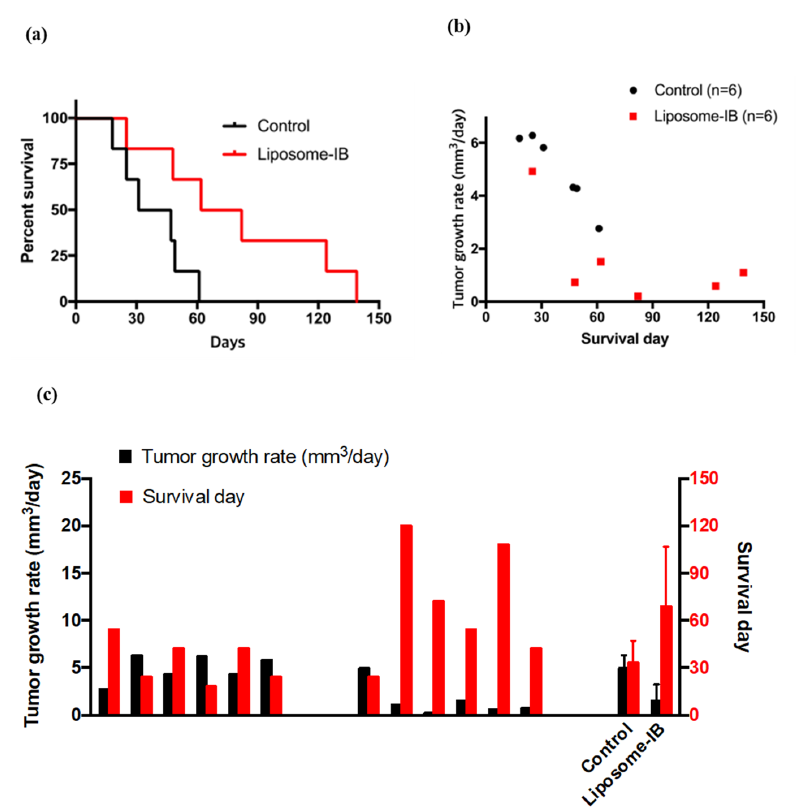
Figure 6. Analysis of Lipo-IB induced survival advantage. ( a ) Kaplan^=Meier curve shows signifi- cantly increased survival of Lipo-IB treated SmoA1 mice compared to control treated mice. ( b ) Pearson correlation analysis between mouse survival time and the tumor growth rate. Pearson correlation coefficient was − 0.78 ( p < 0.02). ( c ) Relationship between tumor growth rate and survival time for individual